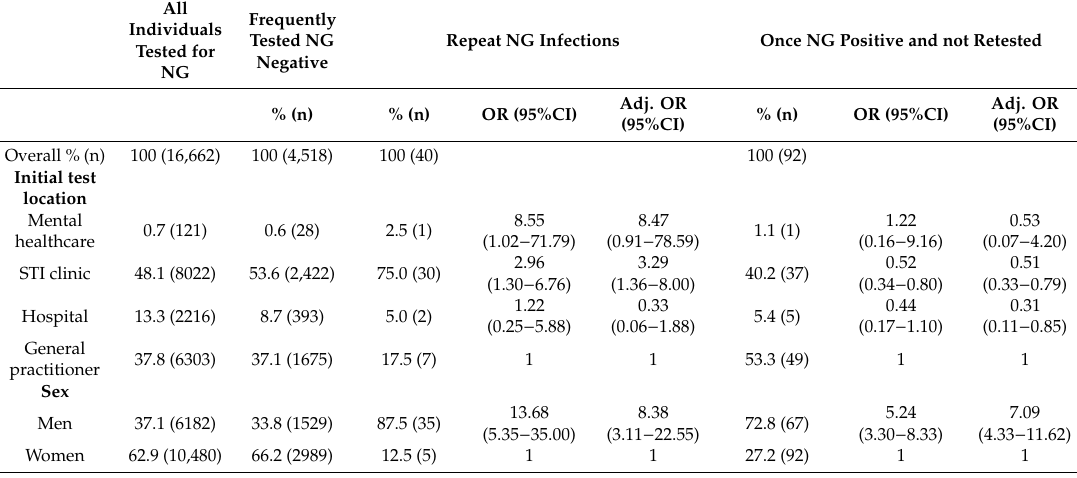
Table 1. Determinants associated with “repeat NG infections”, “Once NG positive and not retested”, and “once NG positive and repeatedly tested NG negative” between January 2011 and July 2018. All